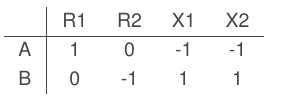
Table 2: Example one: stoichiometric matrix,